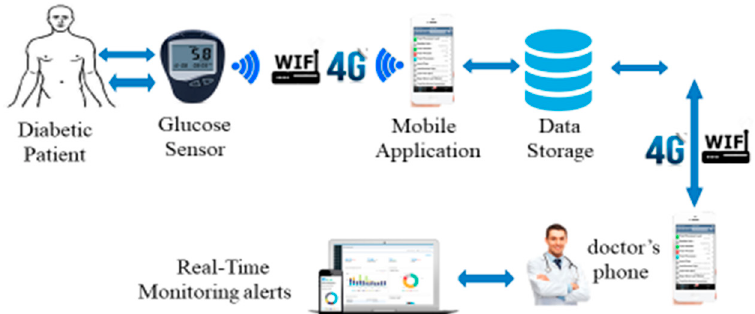
Figure 1. Proposed scenario.